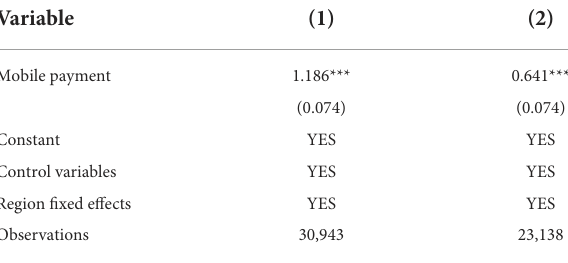
TABLE 9 Mechanism test 2: the impact of mobile payment on family leisure consumption.